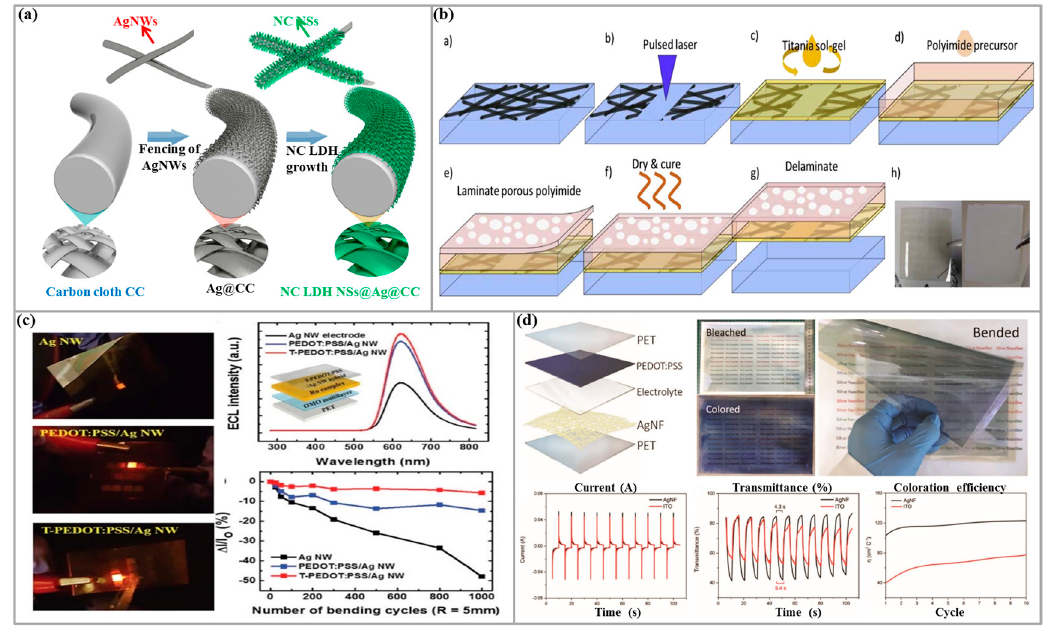
Figure 6. Some applications of the Ag NWs TCE. ( a ) Schematic illustration showing the